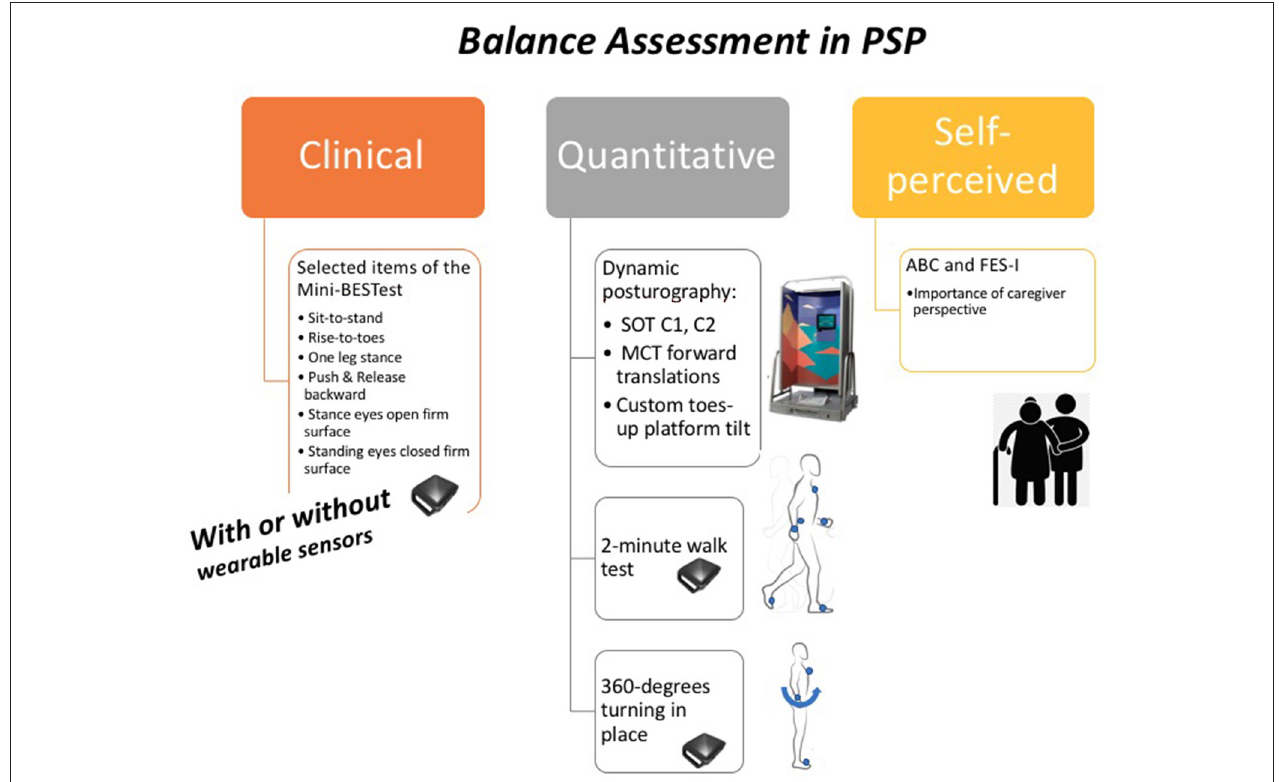
FIGURE 1 | Our balance assessment in PSP protocol. SOT, Sensory Organization Test; C1, condition one (quiet stance without movement of the force plate or surround with eyes open); C2, condition two (quiet stance without movement of the force plate or surround with eyes closed); MCT, Motor Control Test; ABC, Activities-Specific Balance Confidence (ABC) Scale; FES-I, Falls Efficacy